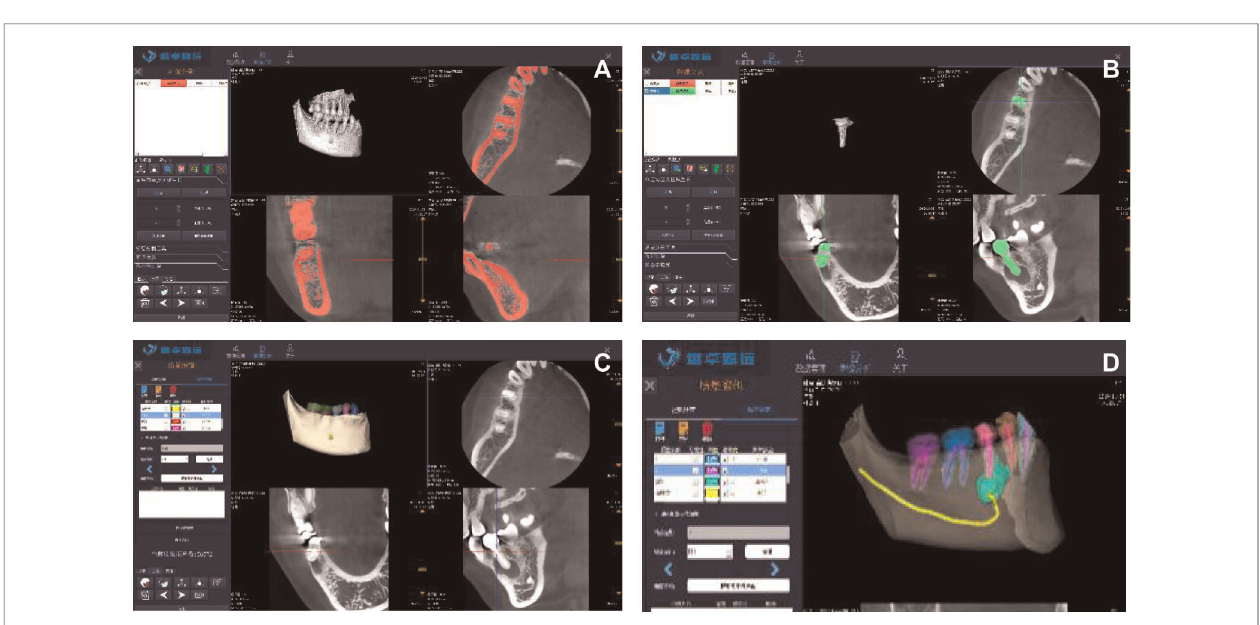
FIGURE 1 | Buccal image and CBCT (NewTom 5G Version FP) examination. ( A ) Buccal image of the affected tooth. ( B ) CBCT image of the